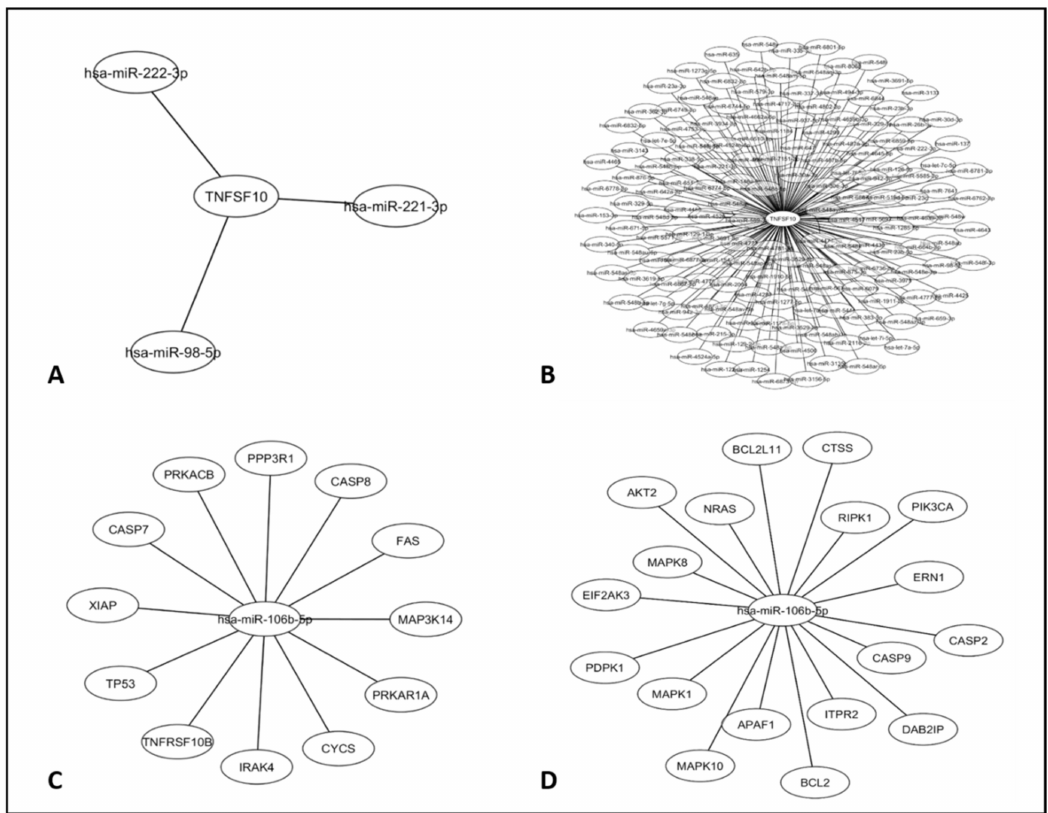
Figure 5. Cytoscape analysis considering TRAIL and miR-106b-5p in the apoptosis pathway. ( A ) Validated miRNAs that interact with the TRAIL ( TNFSF10 ) gene. ( B ) Predicted miRNAs that have TRAIL ( TNFSF10 ) as target gene. ( C ) Validated genes controlled by miR-106b-5p. ( D ) Predicted genes controlled by